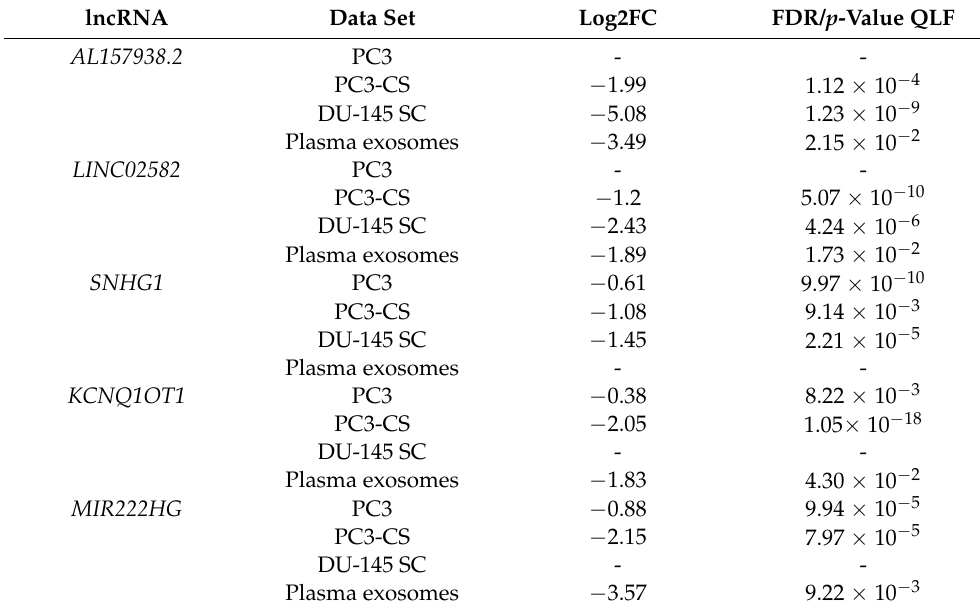
Table 4. List of statistically significant DE lncRNAs associated with the development of resistance to docetaxel.